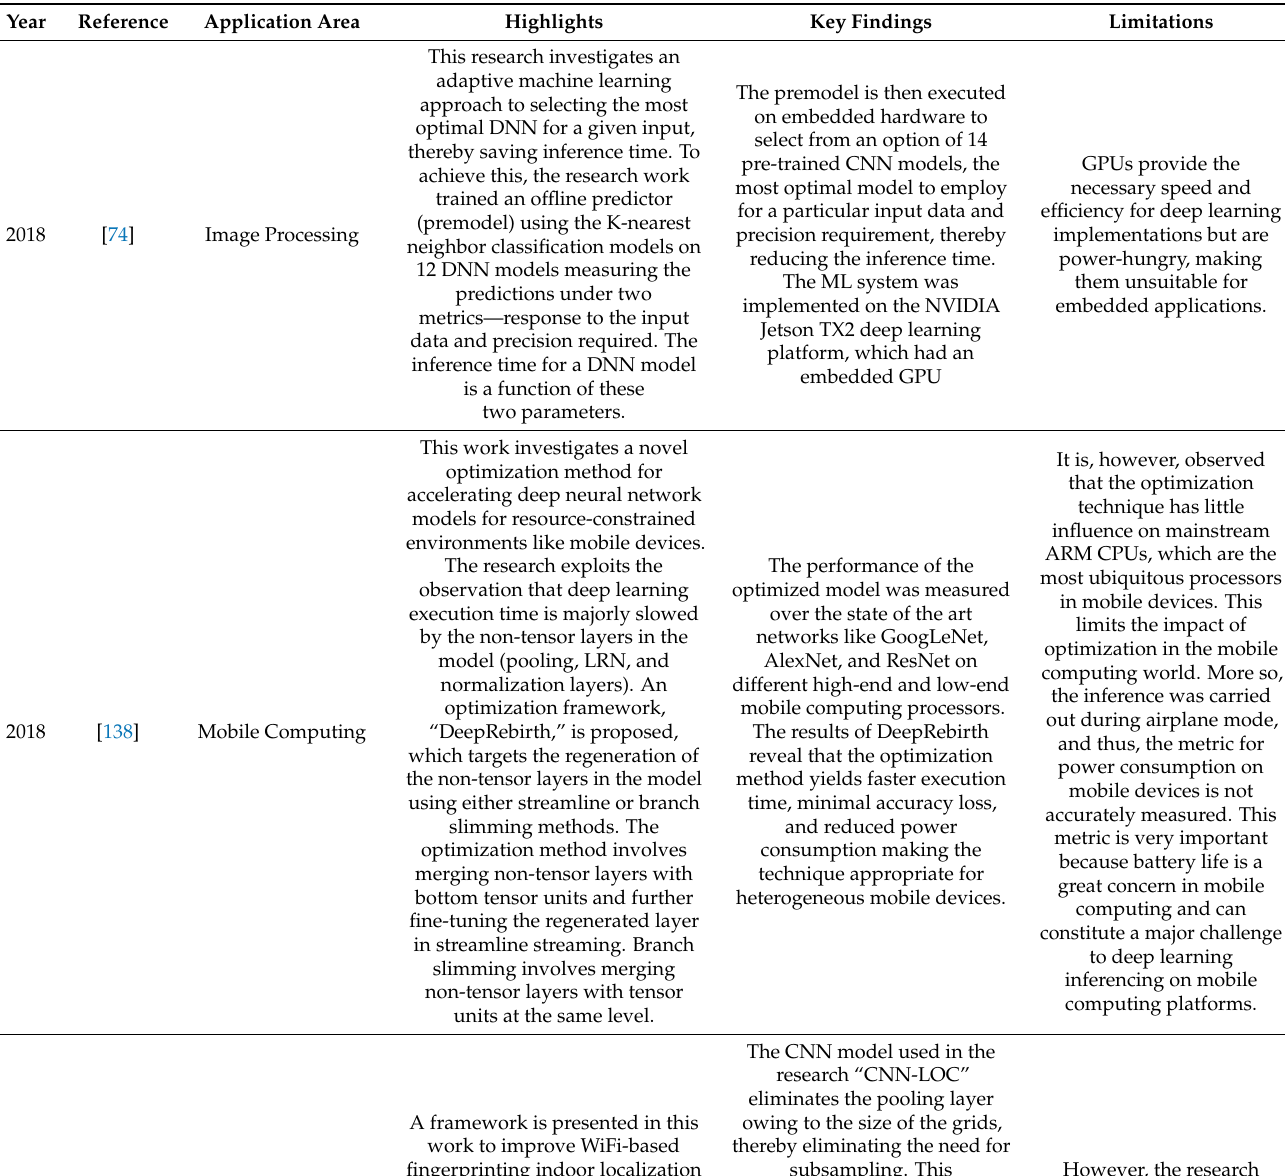
Table 19. Deep learning in mobile